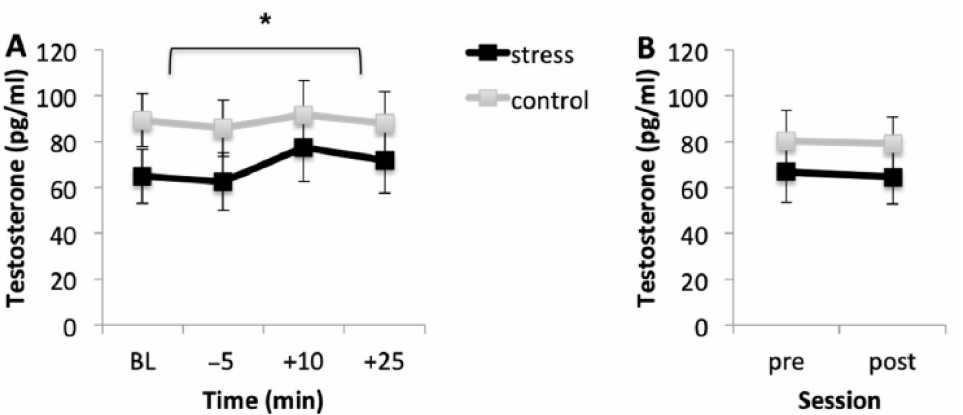
Figure 3. Salivary testosterone levels in the stress and control conditions for the acquisition session ( A ) and for the memory testing session ( B ). Error bars represent standard error of mean (S.E.M.). BL = baseline levels ( − 80 min) (* p <